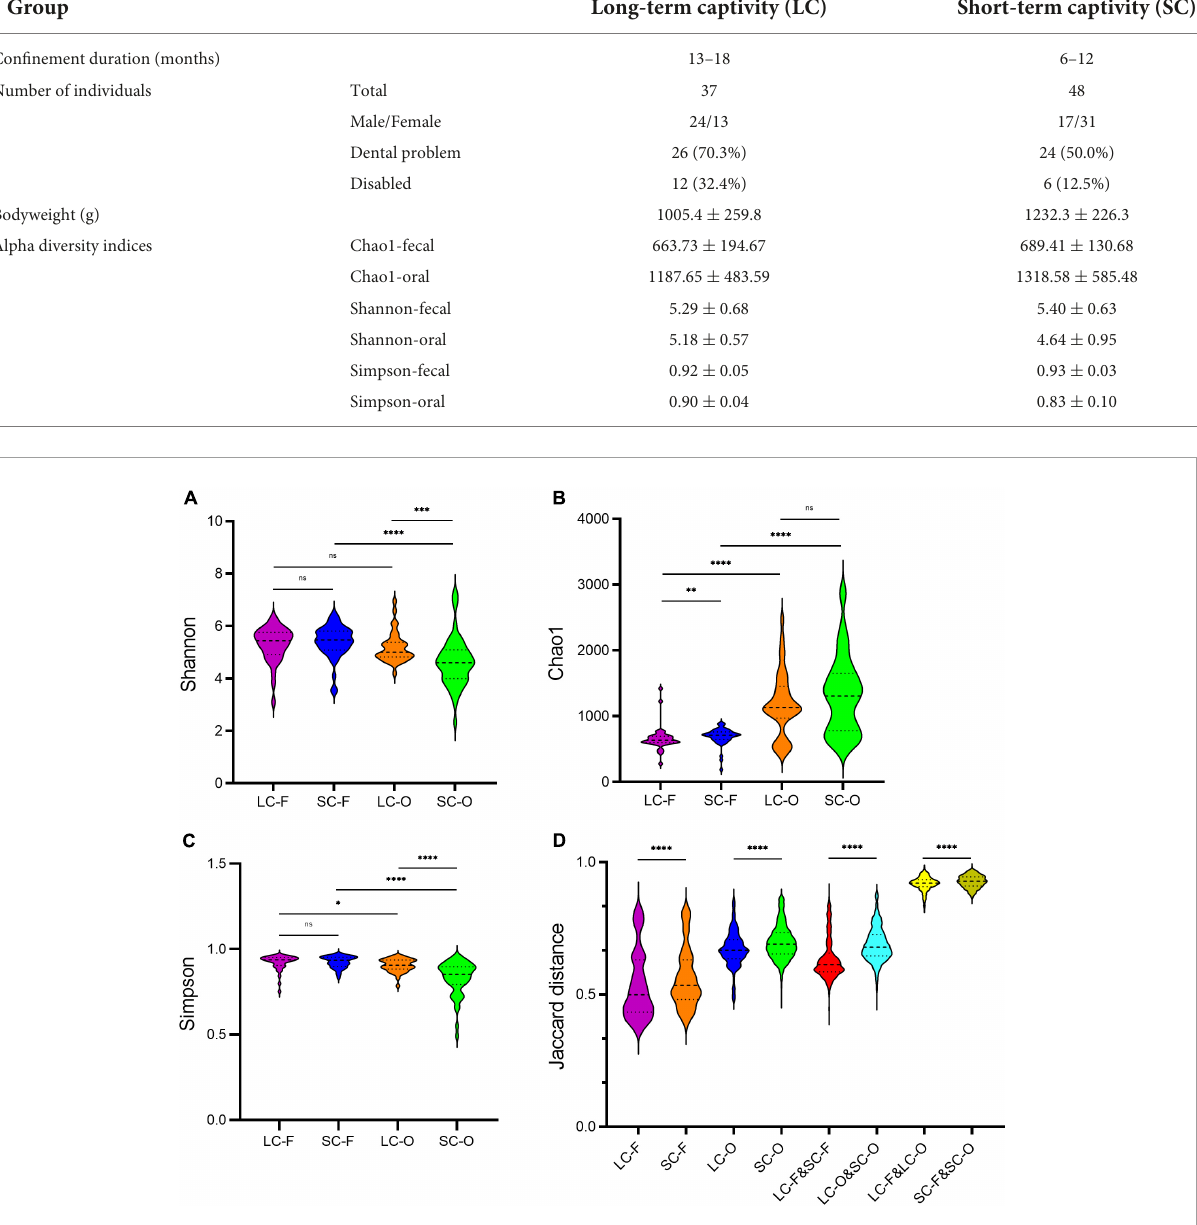
FIGURE1 The alpha and beta diversity in the fecal-oral microbiome of slow loris groups under different confinement durations: long-term captivity-fecal ( LC-F ), short-term captivity-fecal ( SC-F ), long-term captivity-oral ( LC-O ), short-term captivity-oral ( SC-O ). (A) Shannon’s diversity index; (B) Chao1 index; (C) Simpson index; (D) the Jaccard distances of the beta diversity between communities. The differences were tested by Mann–Whitney U test ( ns , not significant, ** P < 0.01, *** P < 0.001, **** P <